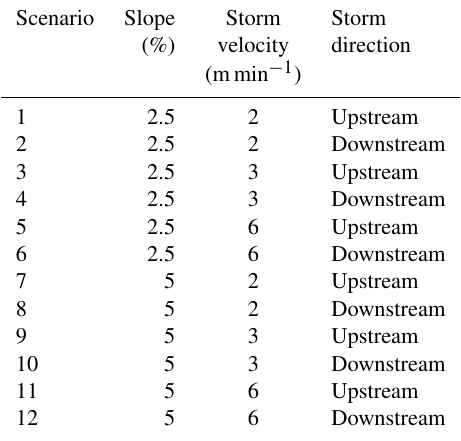
Table 2. Design structure of